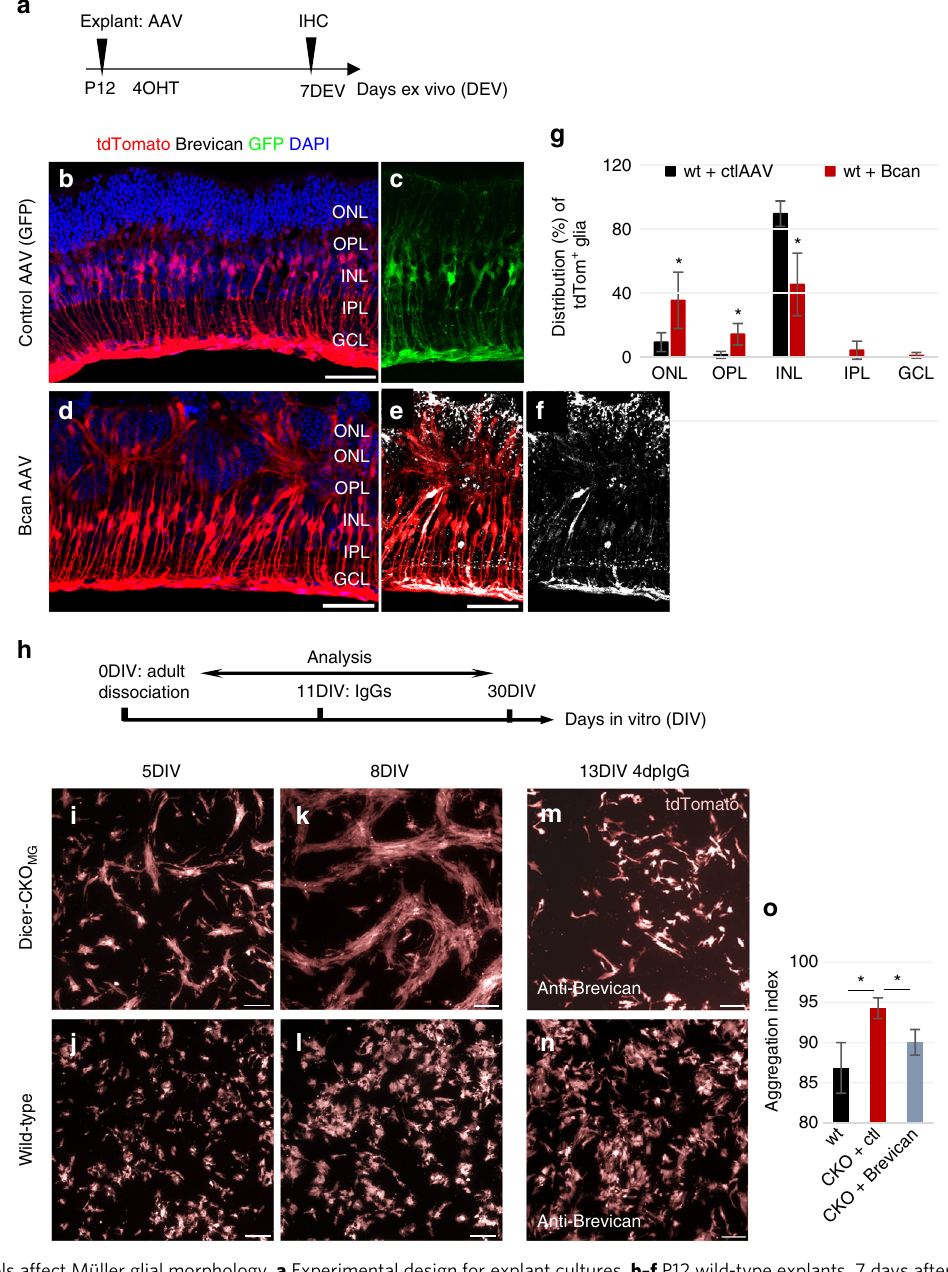
Fig. 5 Brevican levels affect Müller glial morphology. a Experimental design for explant cultures. b – f P12 wild-type explants, 7 days after control-AAV ( b , c ) or Bcan -AAV transduction ( d – f ). Migrating, aggregation-forming MG are Brevican + ( e , f ). g Distribution of MG in the retina layers after control or Bcan - AAV transduction, control-AAV: n = 4 mice, Bcan -AAV: n = 4 mice.This experiment was performed twice in the laboratory. h Cell culture scheme. i – n Live images of cultured tdTomato + MG from adult Dicer-CKO MG ( i , k , m ) and wt mice ( j , l , n ). Adult MG from Dicer-CKO MG mice form cell aggregations over time ( i , k ), which are absent in the wt cultures ( j , l ). Brevican antibody application to Dicer-CKO MG cultures results in resolution of these aggregations after 4 days, but has no effect on the wt glia ( m , n ). o Quanti fi cation of the aggregation index, i.e., the percentage of areas lacking